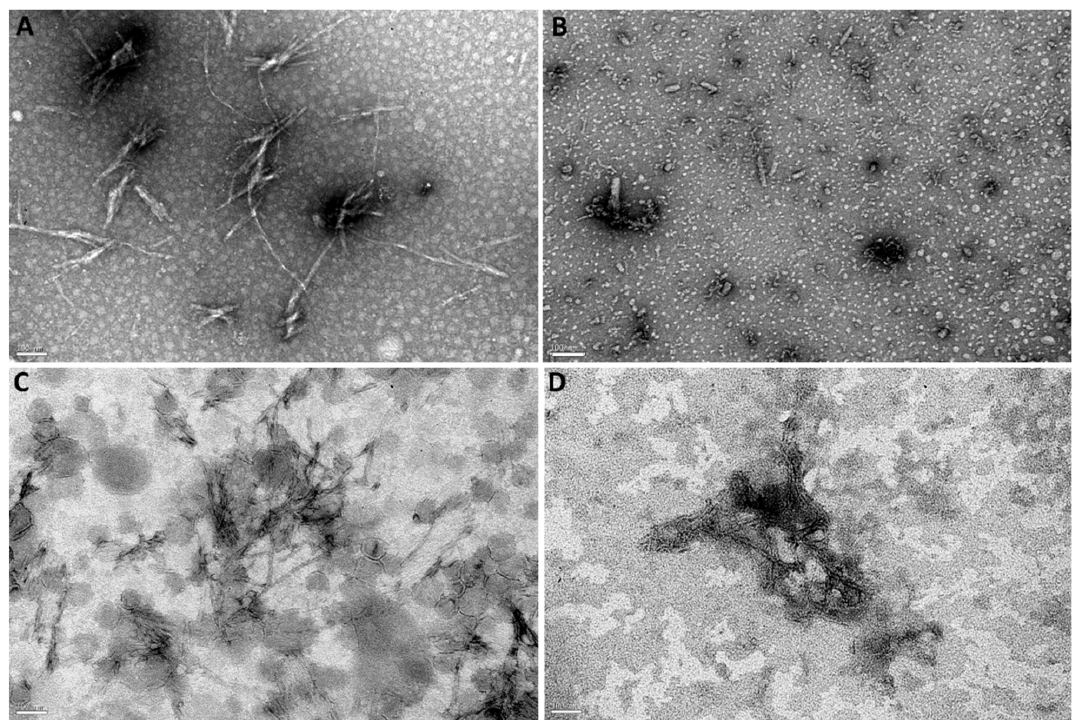
Figure 7. TEM images of ( A ) A β 1-42 incubated with ( B ) GA, ( C ) Tf-functionalized liposomes, and ( D ) GA-loaded Tf-functionalized liposomes for 5 h at 37 ◦ C. Scale bars correspond to 100 nm.